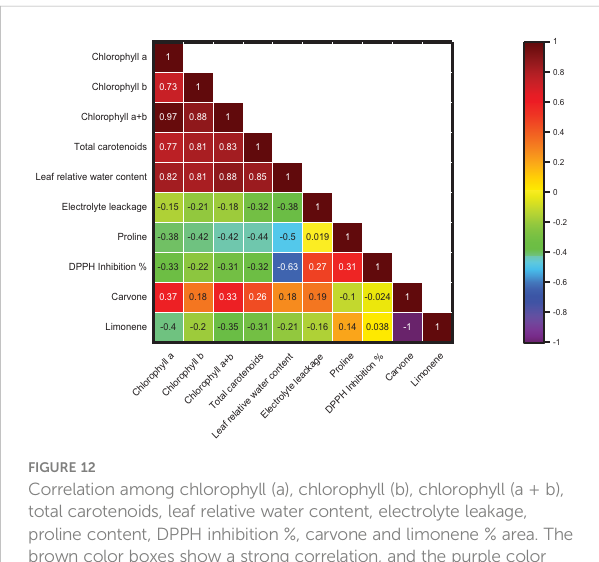
FIGURE 12 Correlation among chlorophyll (a), chlorophyll (b), chlorophyll (a + b), total carotenoids, leaf relative water content, electrolyte leakage, proline content, DPPH inhibition %, carvone and limonene % area. The brown color boxes show a strong correlation, and the purple color boxes show a weak